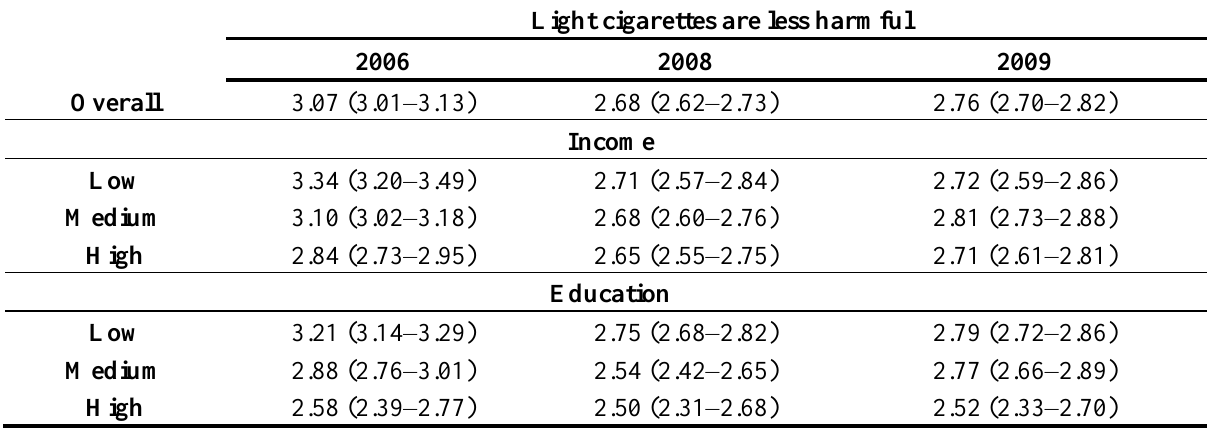
Table 2. Adjusted mean a (95% CIs) level of agreement with ―light cigarettes are less harmful‖ b